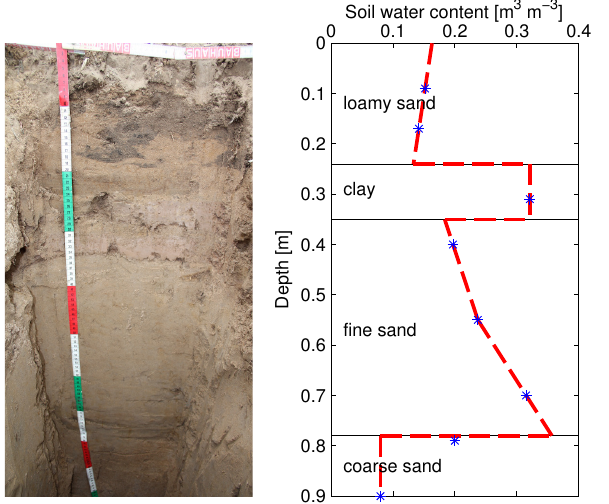
Fig. 8. Soil structure and soil water content distribution at the posi- tion 40m in the measured line p13 on 29 May 2011. The red dashed line is the interpolated soil water content distribution from TDR measurements (blue stars).